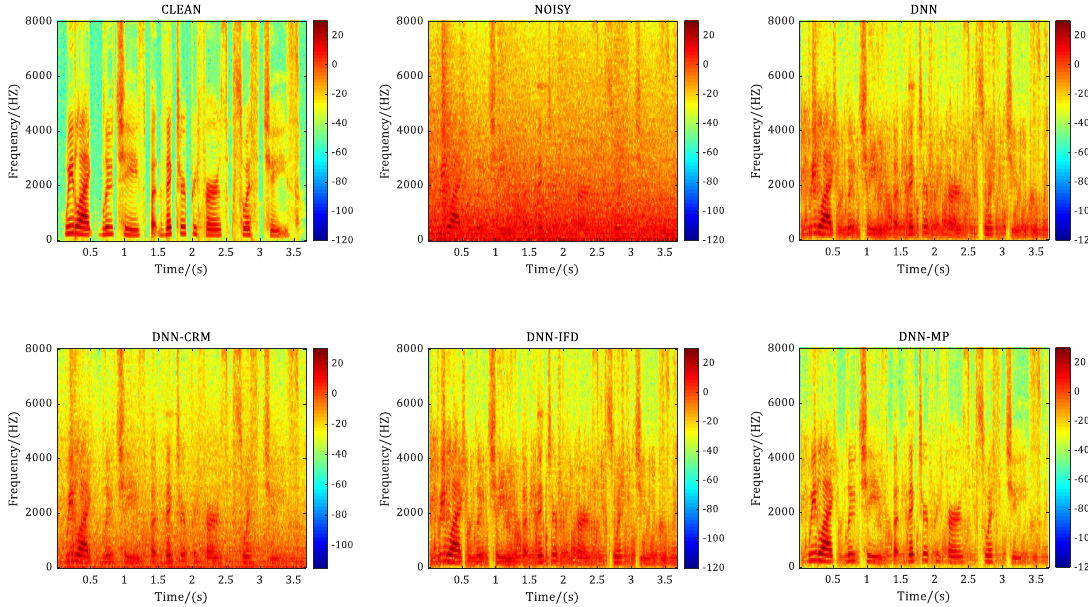
Figure 6. Performance comparison in terms of spectrogram for babble noise at − 5 dB SNR level.